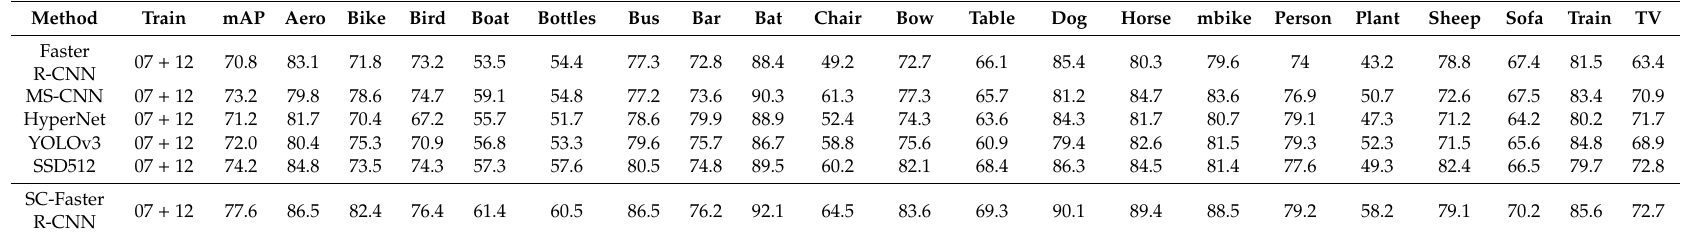
Table 4. Result of PASCAL VOC 2007 test set (%). Training data: 07 + 12: VOC 2007 and 2012 train +